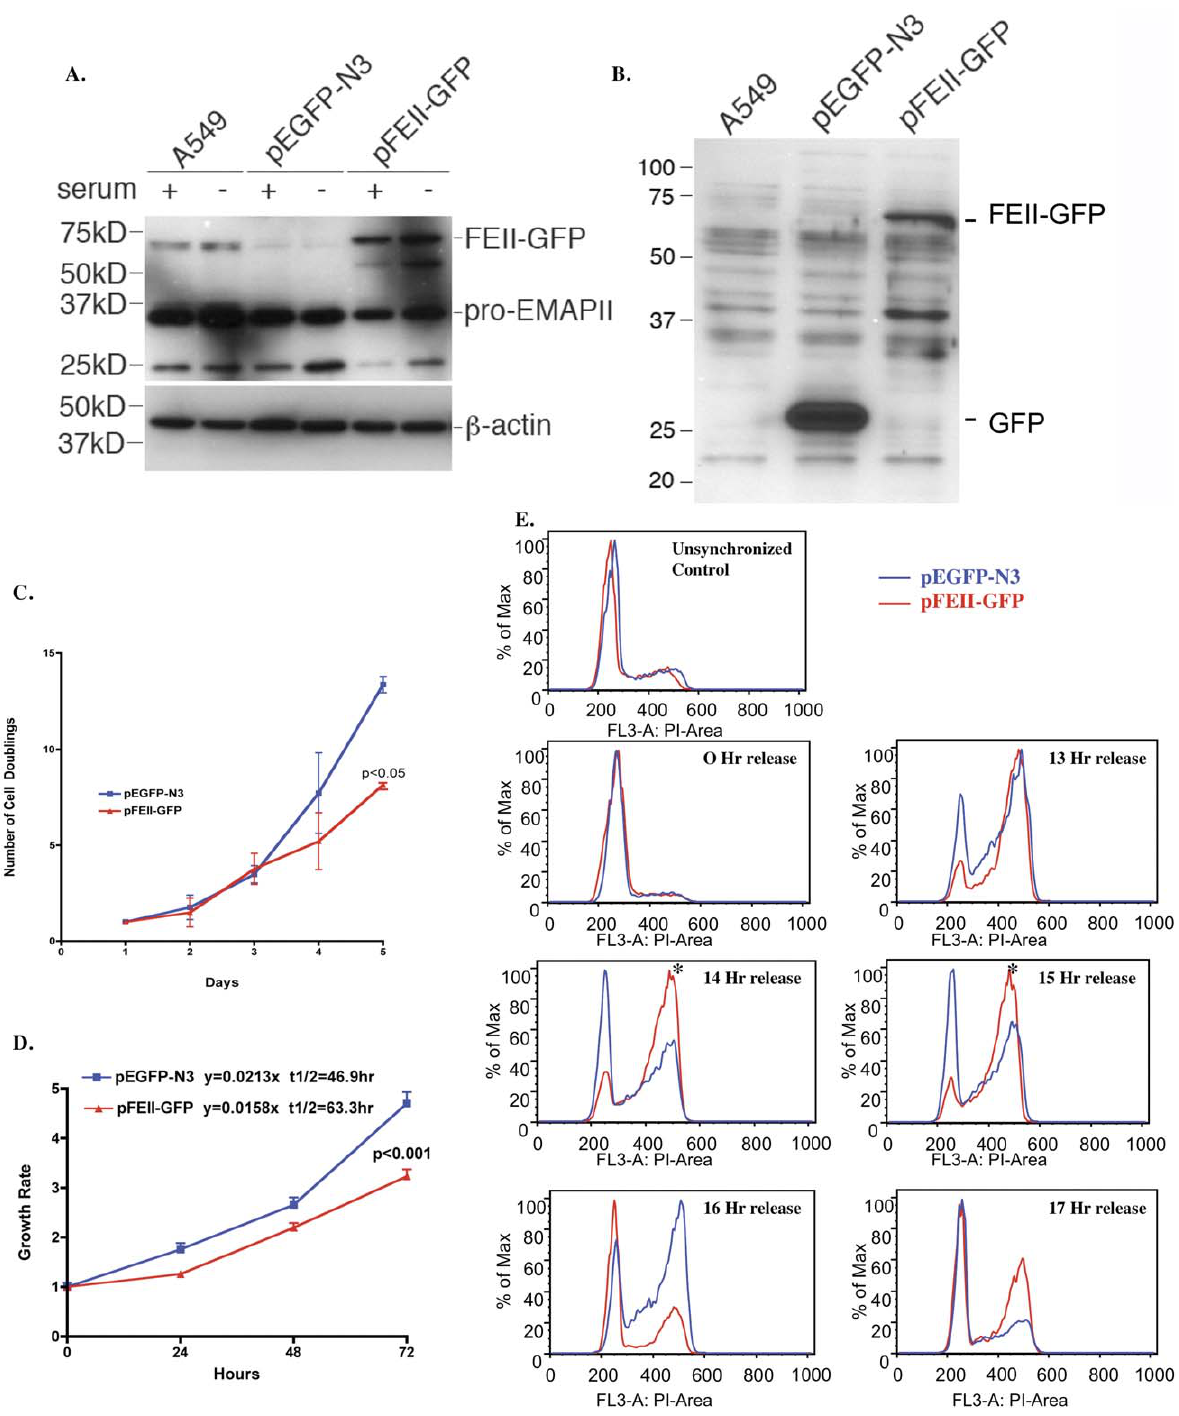
Figure 1. EMAP II overexpression delays cell proliferation. Cell doubling, proliferation and progression through cell cycle were examined in clonal A549 cell populations overexpressing either EMAP II (pFEII-GFP) or GFP (pEGFP-N3). Western analysis of cell lysates using either EMAP II (A) or GFP (B) antibody confirmed expression. EMAP II overexpressing cells were found to have a marked delay in cell doubling (C, p , 0.05), growth rate (D, p , 0.001), and a delay in exiting the G2M phase of cell cycle as noted at 14 and 15 hours post synchronized cell release (*, E) as compared to the empty vector control (pEGFP-N3) (these experiments were performed a minimum of 4 times).